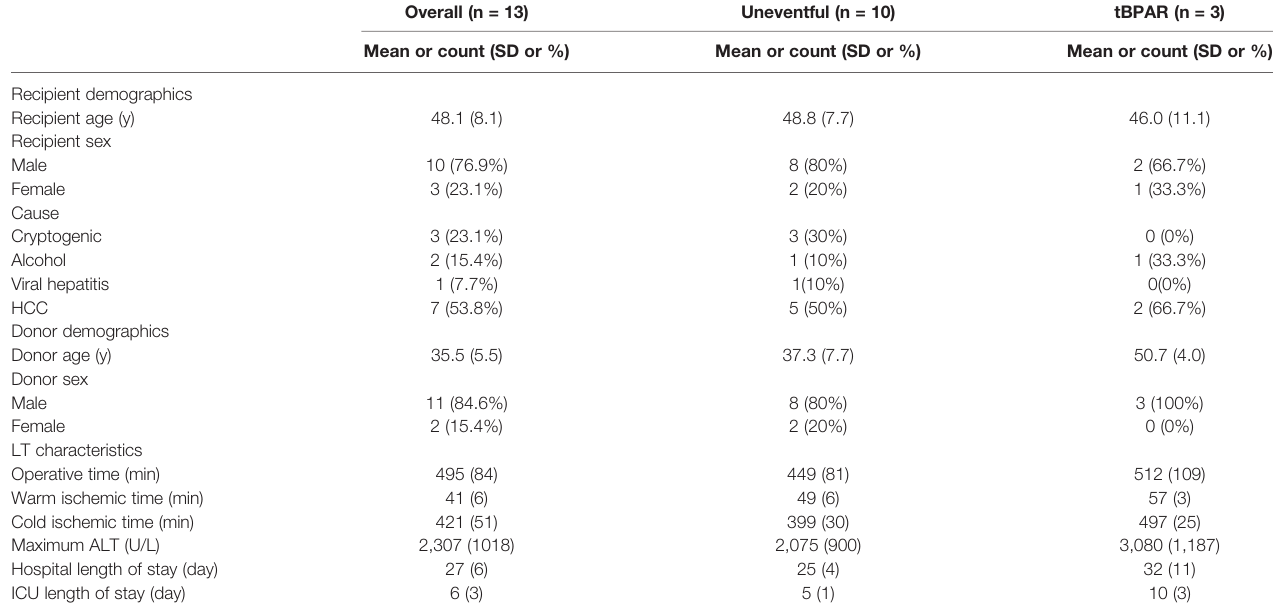
TABLE 3 | Characteristics of the base